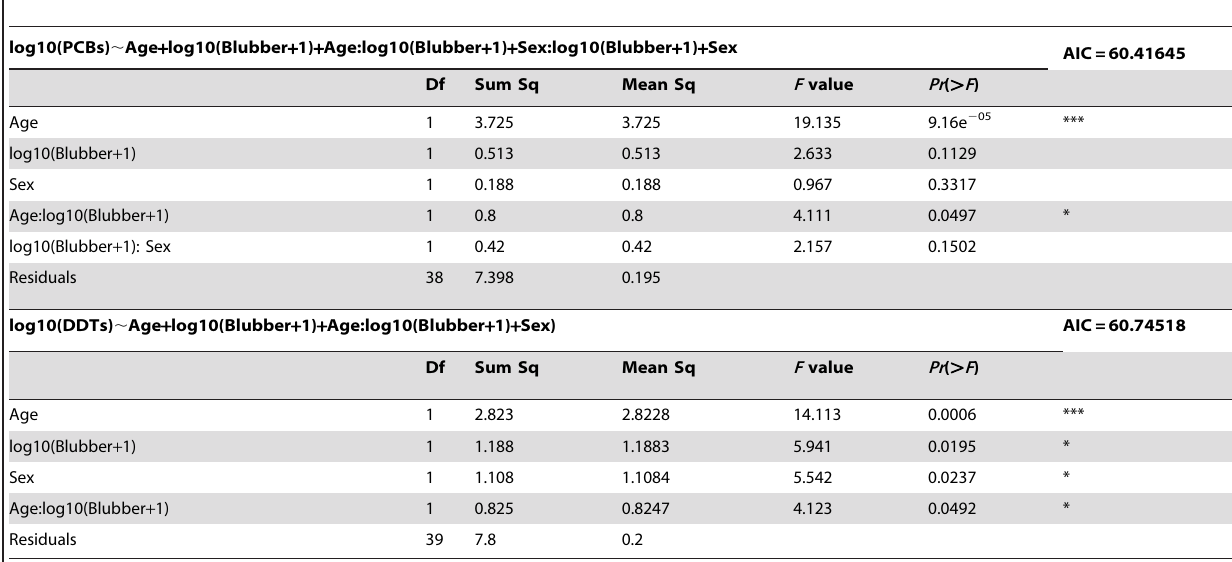
Table 3. Anova tables for highest ranked PCB and DDT models containing the 3 main terms Age, log10(Blubber + 1), and